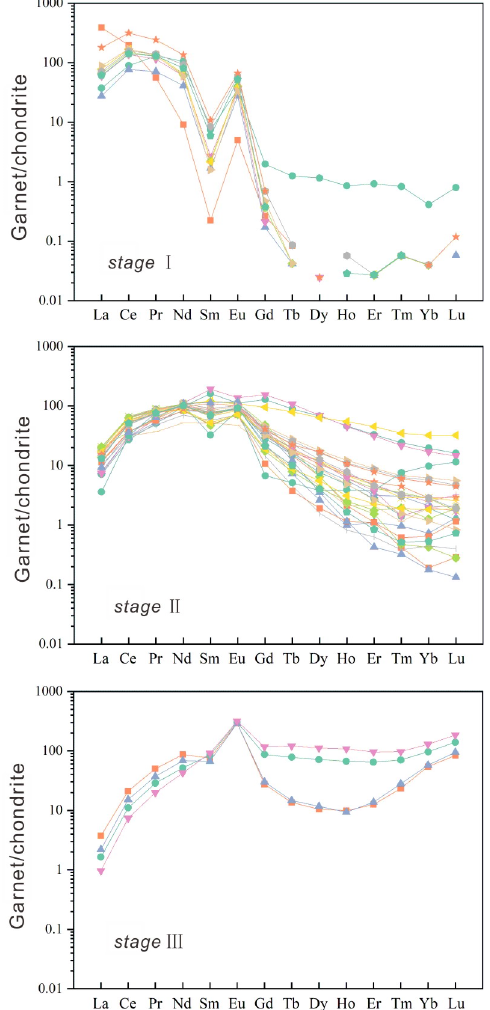
Figure 6. Chondrite-normalized REE patterns of the garnets from the Nanminghe iron